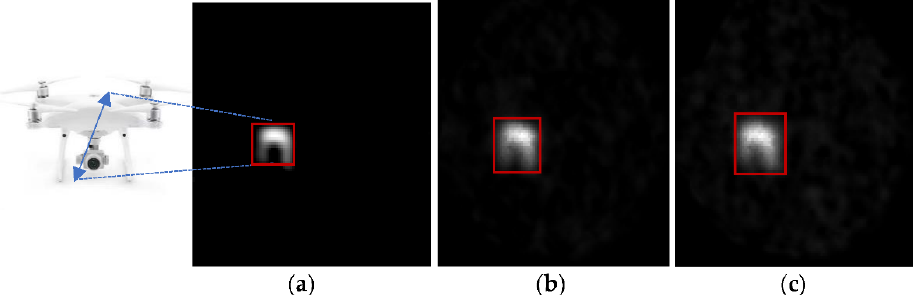
Figure 13. Comparison of imaging effects of a dual-FSM 3D GISC LiDAR system with existing control algorithms at different speeds of a UAV ( a ) UAV hovering; ( b ) UAV V = 2 m/s; ( c ) UAV V = 7 m/s.